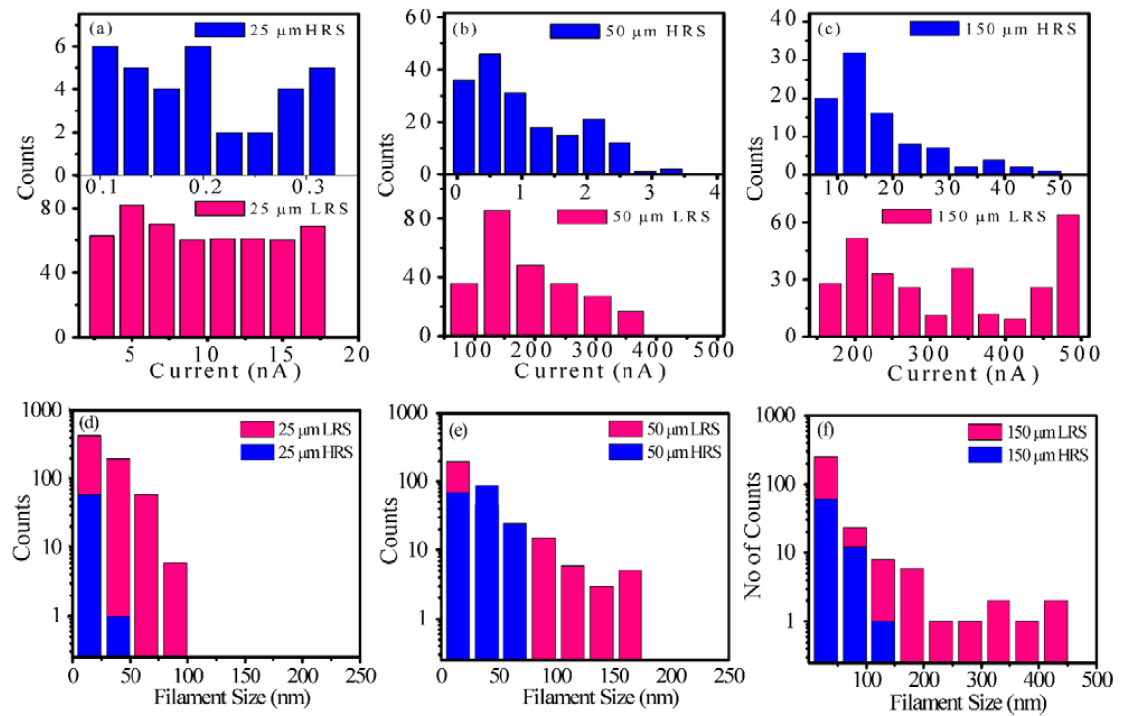
Figure 3. Current distribution historgrams obtained from CAFM images in the HRS and LRS corresponding to device sizes of ( a ) 25; ( b ) 50; and ( c ) 150 µm; ( d – f ) show the size distribution histograms obtained from CAFM images in the HRS and LRS corresponding to devices having different dimensions. Reprinted from [57]. Copyright 2012 IOP